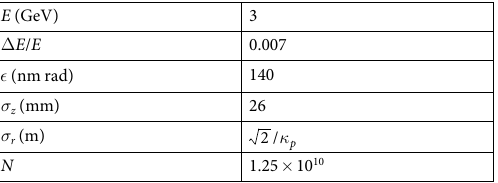
Table 1. Diamond beam parameters. E is the electron energy, Δ E / E is the longitudinal energy spread,  is the emittance, σ z is the beam length, σ r is the beam radius and N is the number of electrons.